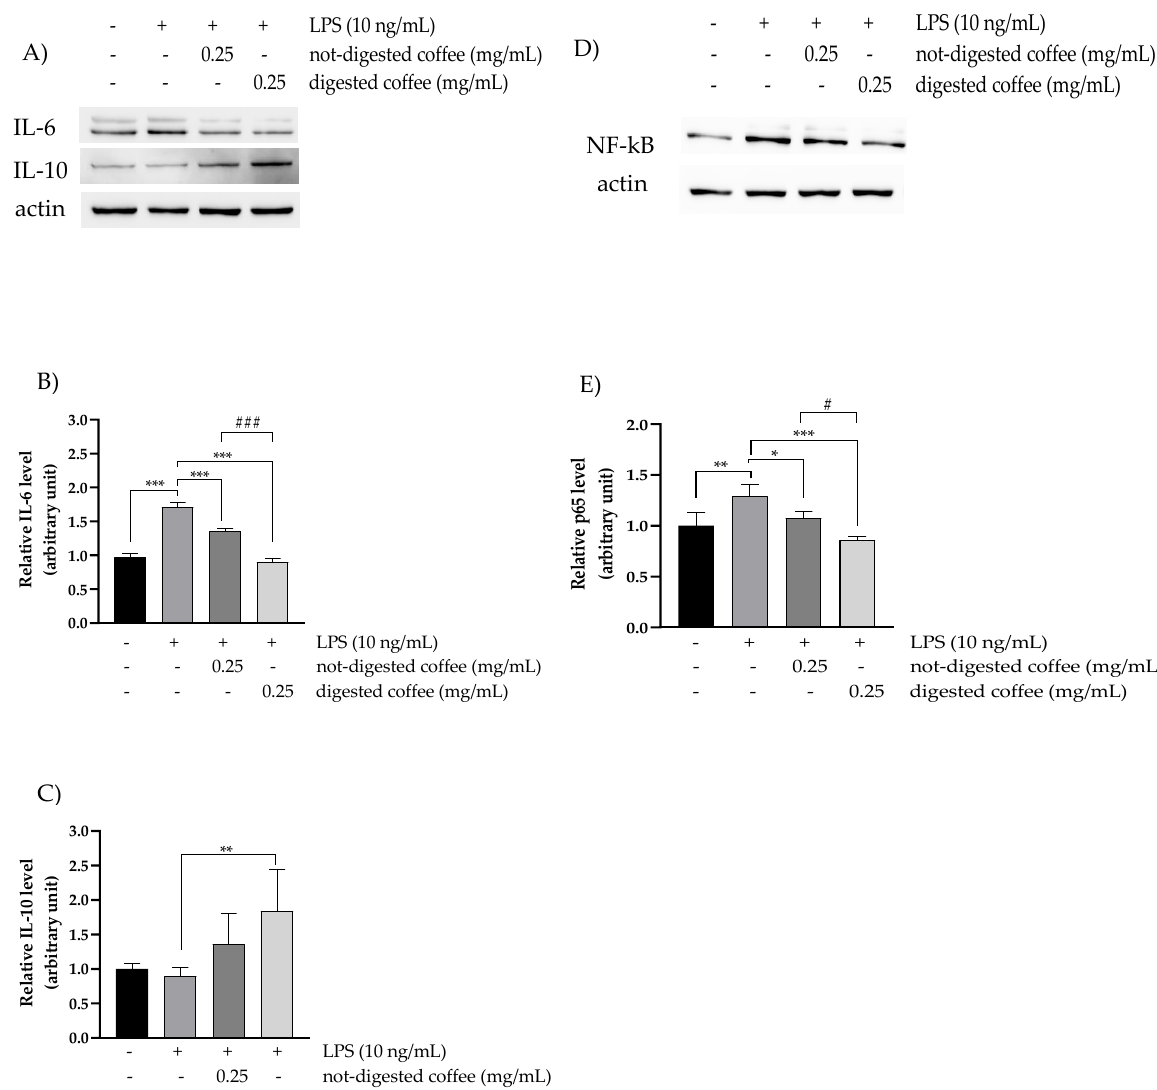
Figure 3. Anti-inflammatory effects of digested coffee samples in LPS-stimulated HT-29 cells. Western blot analysis of the expression levels of interleukin-6 (IL-6) ( A ), interleukin-10 (IL-10) ( A ), and NF-kB (p65 subunit) ( D ) in total cell lysates from untreated control and LPS-stimulated HT-29 cells treated for 48h with not-digested coffee or digested coffee samples loading. ( B , C , E ) Densitometric analysis of Western blots. Band intensities were quantified and normalized to actin used as control. All data were analyzed for statistical significance by two-way ANOVA, followed by Dunnett’s multiple com- parison test where appropriate. Differences were considered significant when p- value ≤ 0.05 and p -value ≤ 0.01 and highly significant when p -value ≤ 0.001. * p ≤ 0.05, ** p ≤ 0.01, and *** p ≤ 0.001 versus untreated control (calculated as fold-change relative to untreated cells, arbitrarily set at 1); # p ≤ 0.05, ## p ≤ 0.01, and ### p ≤ 0.001 not-digested coffee versus digested coffee. Differences were considered significant when p -value ≤ 0.05 and highly significant when p -value ≤ 0.0001. * p -value ≤ 0.05, ** p -value ≤ 0.0001 versus LPS-stimulated control; # p -value ≤ 0.05, ## p -value ≤ 0.0001 not-digested coffee versus digested coffee.